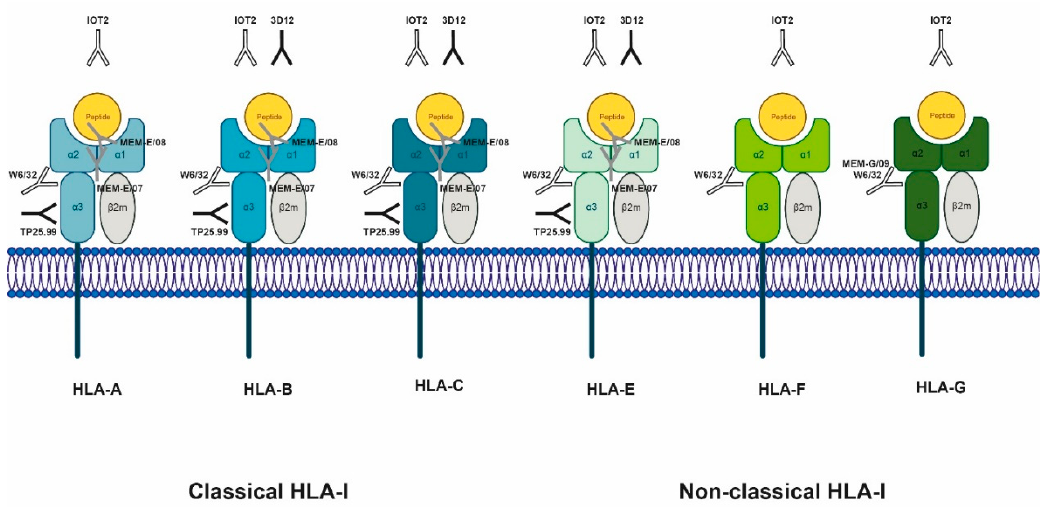
Figure 1. Reported target specificity of anti-HLA-I antibodies frequently used in sHLA studies . The binding domain of each antibody is represented by its location relative to the HLA complex. The color of the antibody indicates its specificity for native (conformational) or linear (non-conformational) epitopes. Open = native, grey filled = linear, and black filled = both. Studies reporting the depicted antibody specificities are mentioned in the main text. Antibodies for which no specific epitopes were reported are depicted above the HLA complex.